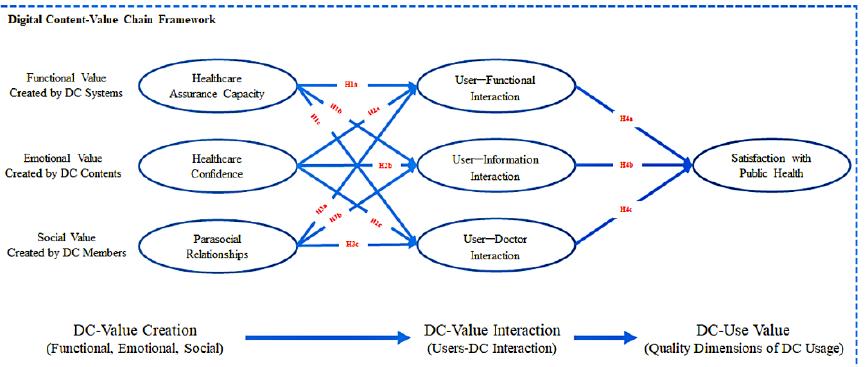
Figure 2. Proposed research